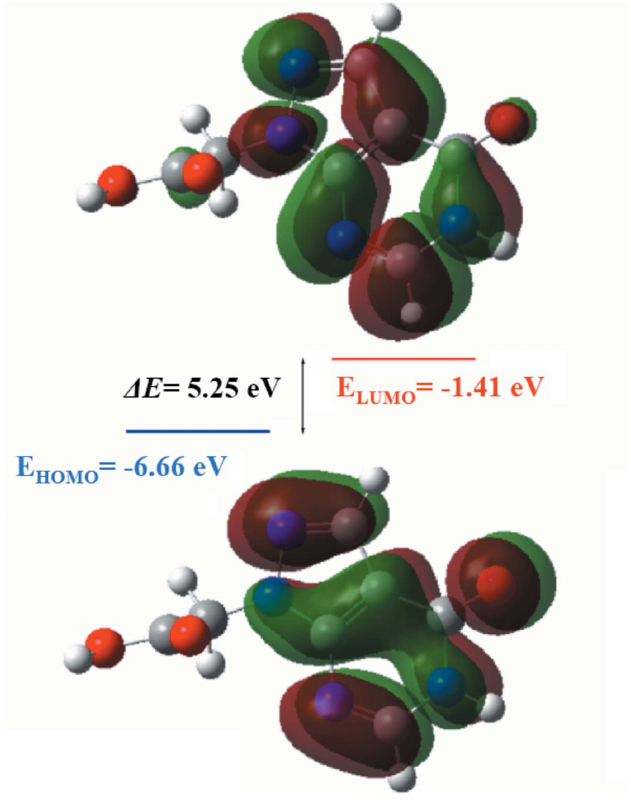
Figure 10 The optimized frontier molecular orbitals (HOMO and LUMO) with the energy band gap of (I).